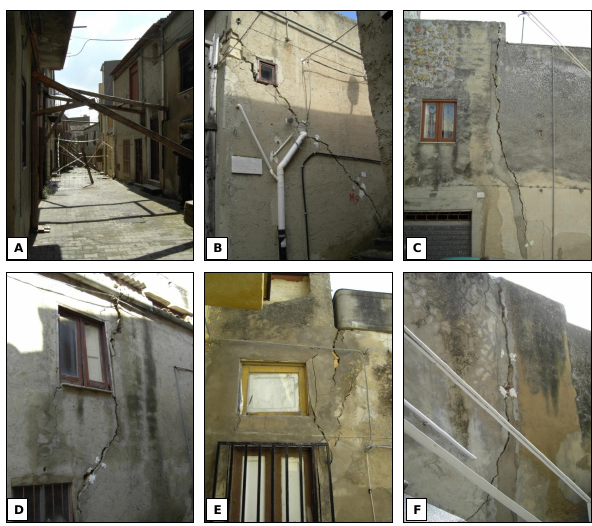
Fig. 4. Overview of Vanelle St. in Naro (A) and examples of centimetre fractures in the buildings located on its northern side (B–F) . These structural damages are connected with ground and structural instability that occurred on 4 February 2005 (photos taken on 5 April 2007).